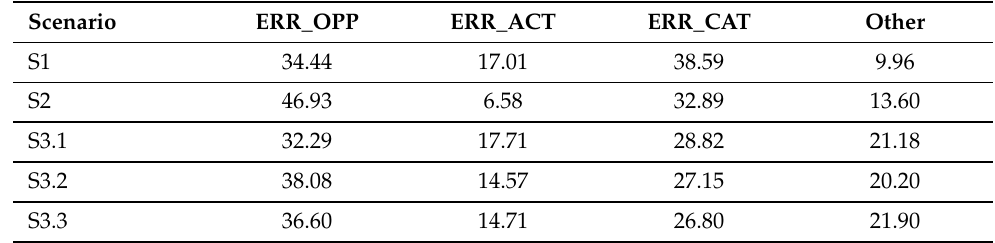
Table 4. Intent detection—error type distribution